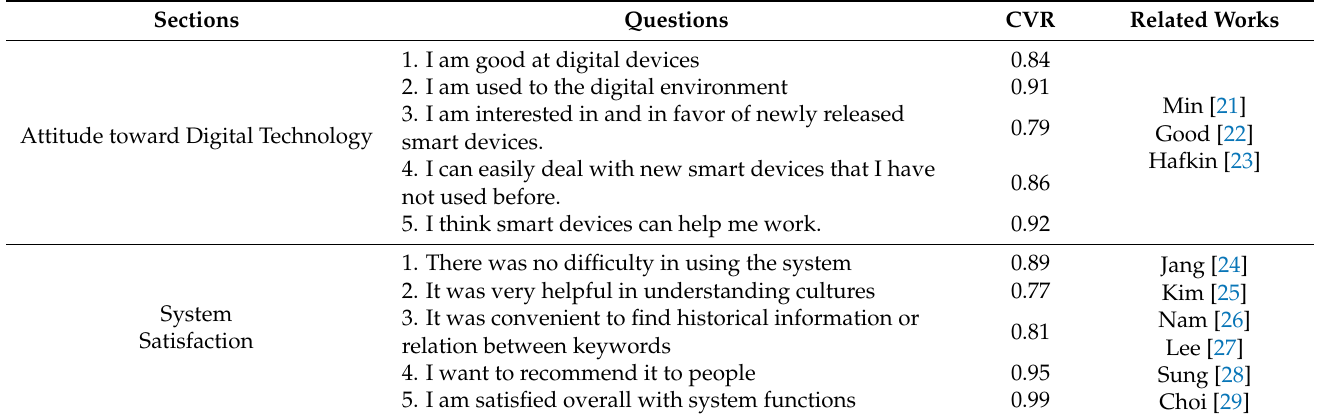
Table 2. Questionnaire for System